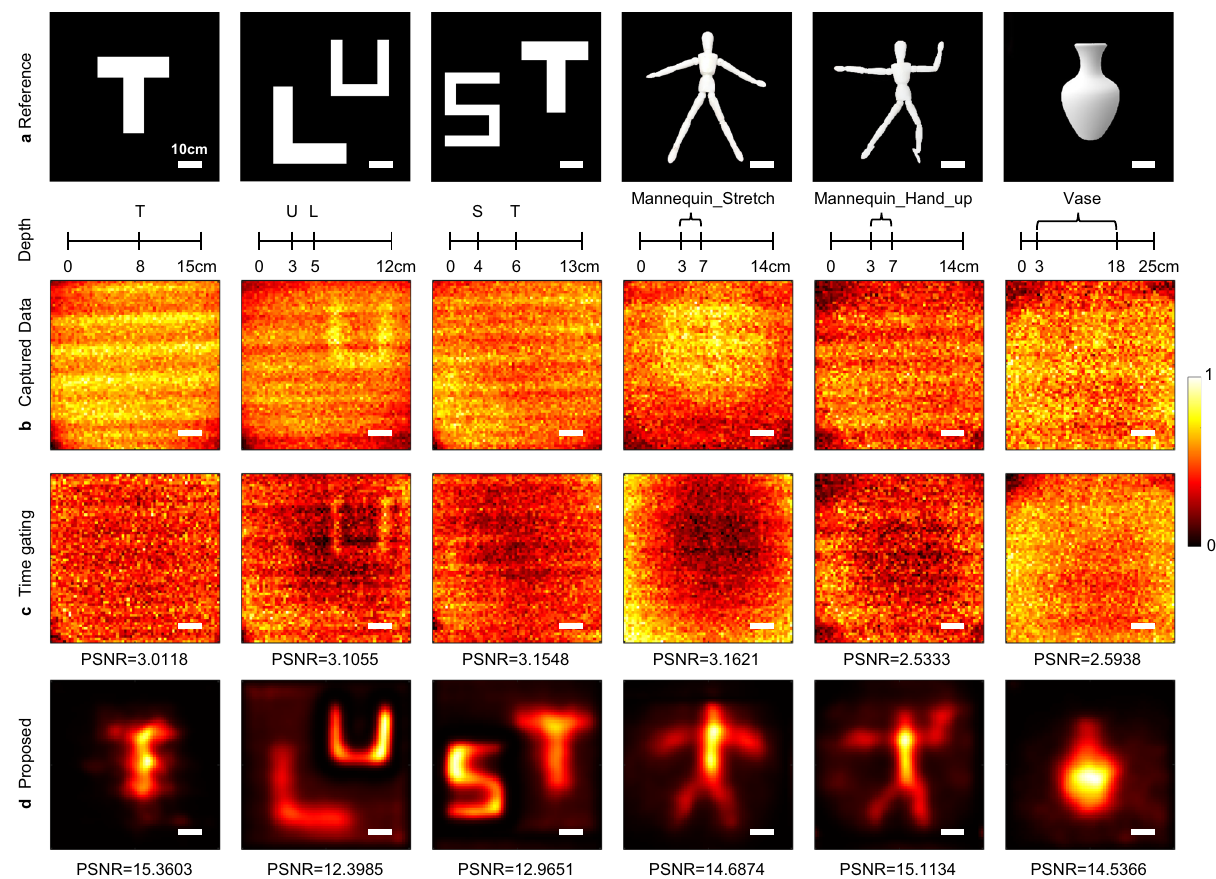
Fig. 5 Comparisons on reconstructing Lambertian objects in the polyethylene foam. a References of 2D, multi-depth, and 3D Lambertian objects used in this experiment. The total thicknesses of polyethylene foam and object depths are marked in the scale below each picture. Taking the letter ‘ T ’ in the fi rst column as an example, the total thickness of the foam is 15 cm and the ‘ T ’ is located at 8 cm. All scale bars indicate 10 cm. b Images directly captured by the detector. c Time-gated results which are taken by combining multiple time bins corresponding to the object depths. d Reconstructions using the proposed method. The peak signal-to-ratio (PSNR) is calculated as the quantitative indicator to compare time gating and the proposed algorithm using the references in ( a ). The results are marked in ( c , d ). PSNR is in